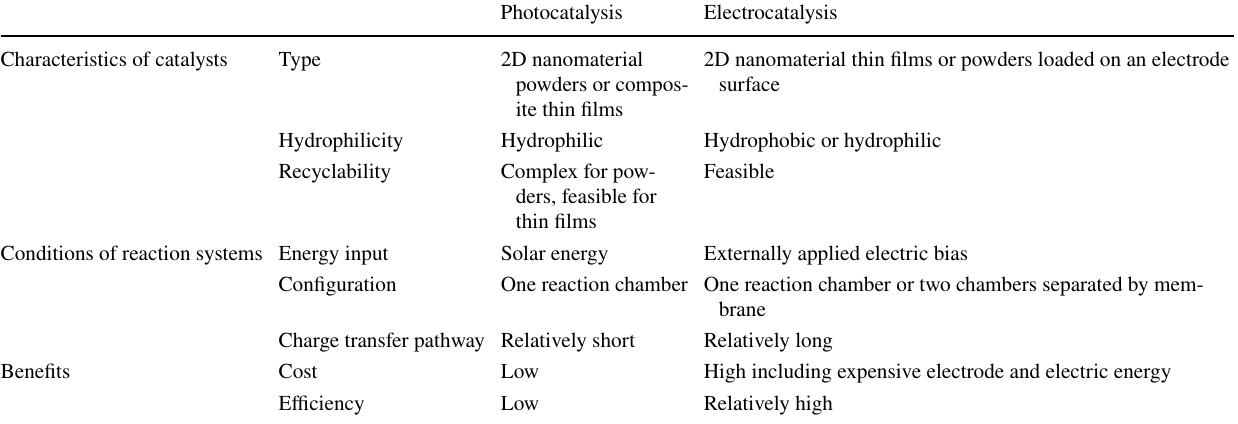
Table 1 Comparison of differences and similarities for photocatalysis and electrocatalysis in 2D